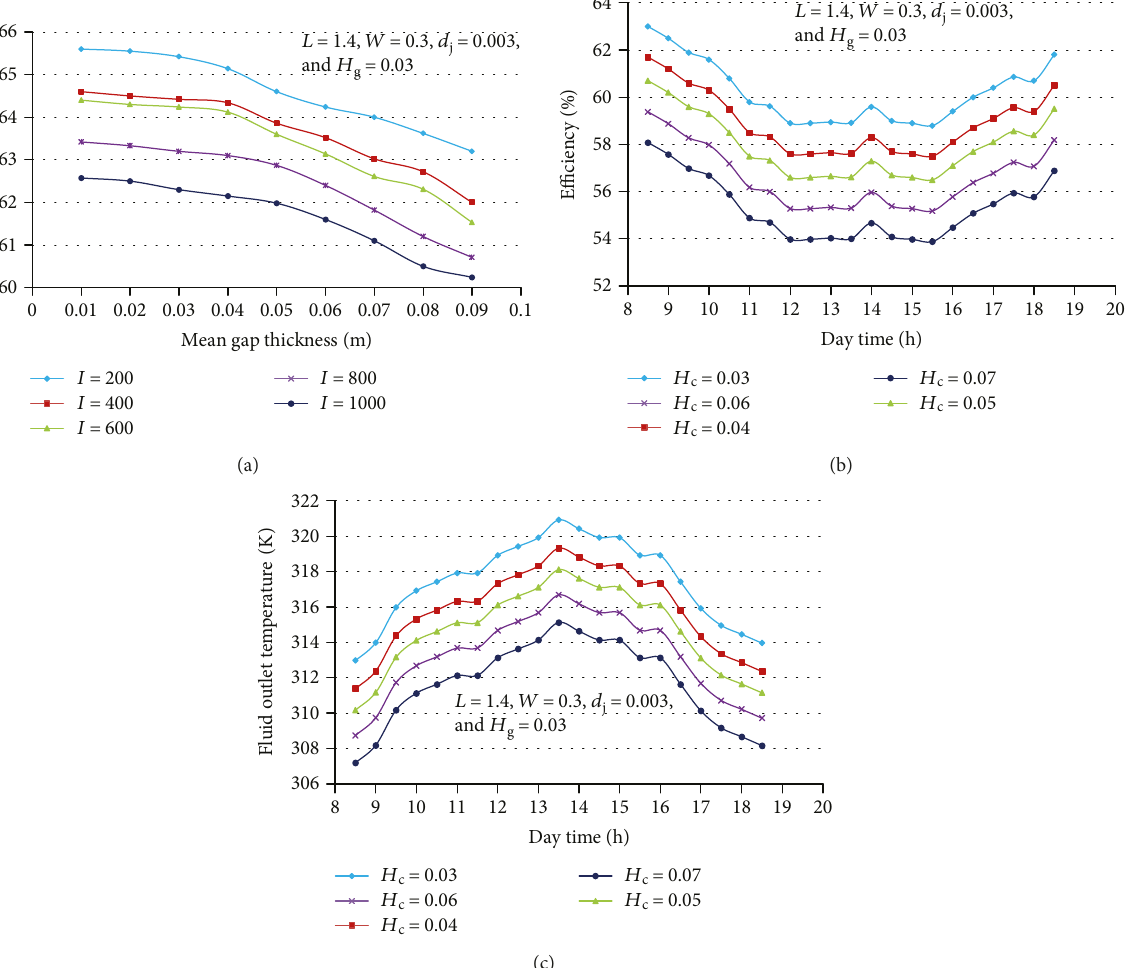
Figure 23: Prediction of the optimum mean gap thickness between the absorber plate and the glass cover ( H at di ff erent solar radiation levels. (b) Hourly SAH e ffi ciency over daytime at di ff erent H (a) SAH e ffi ciency versus H c temperature at di ff erent H c